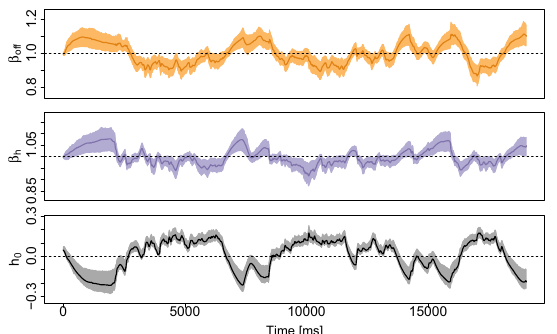
Figure 4. Filtered values of β off , β h , and h 0 ( t ) for salamander retina data, showing the average value across the 297 experiments and the 90% confidence interval (i.e. 268/297 of the filtered values stay within the